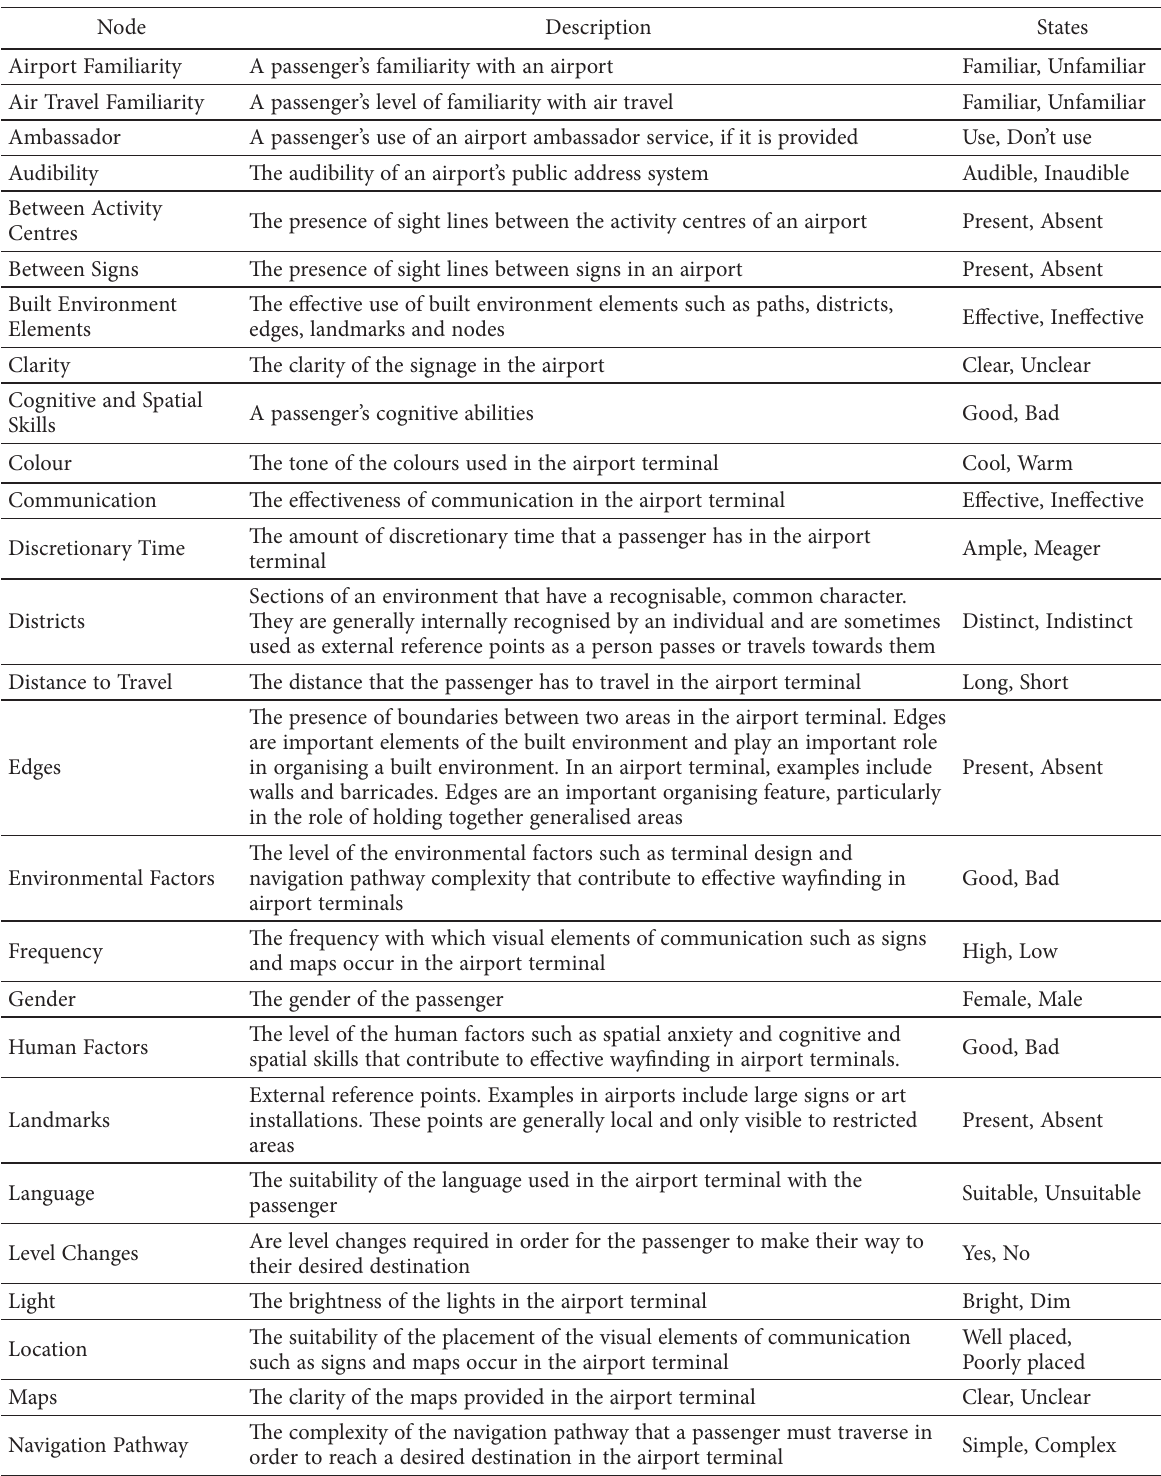
Table 1. Nodes and states of the Wayfinding Bayesian network